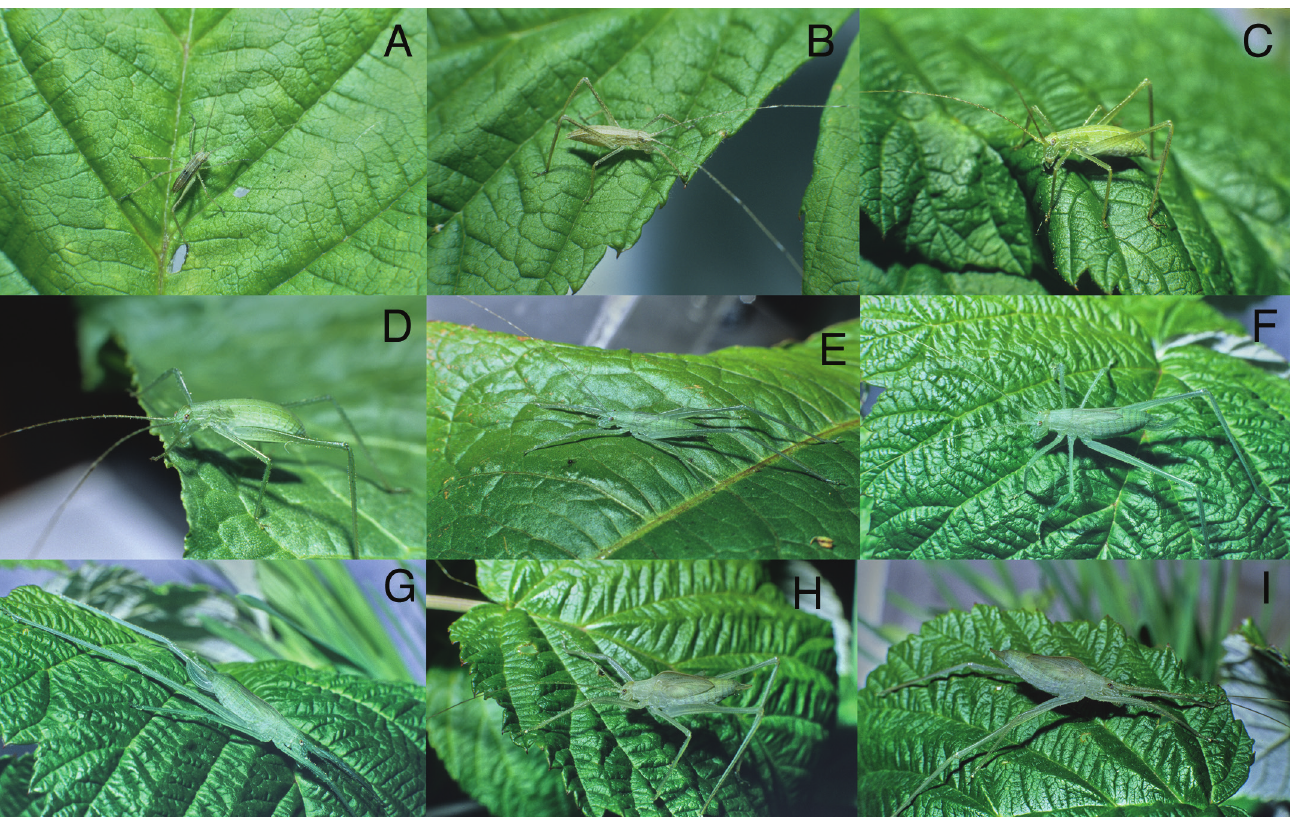
Figure 19. Nymphs of Ectadia fulva . A. First stage, B. second stage, C. third stage, D. 4 th stage, E. 5 th stage, male, F. 5 th stage, female, G. 6 th stage, female, H, I. 6 th stage, male.